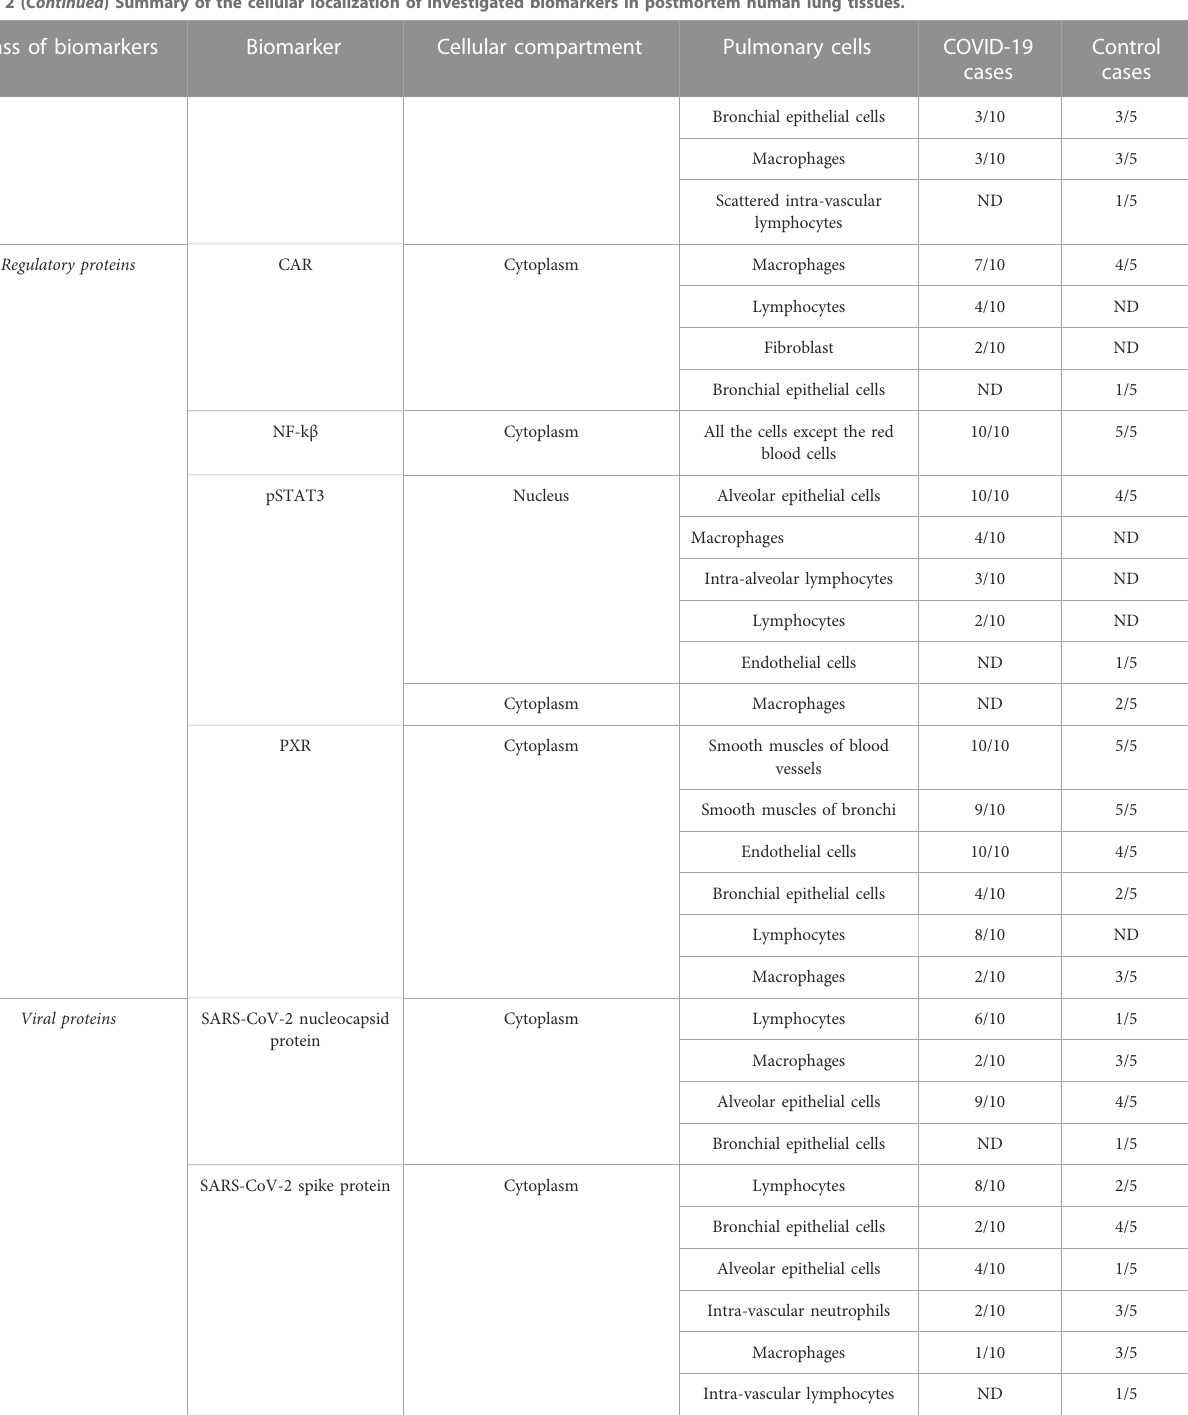
TABLE 2 ( Continued ) Summary of the cellular localization of investigated biomarkers in postmortem human lung tissues. Class of